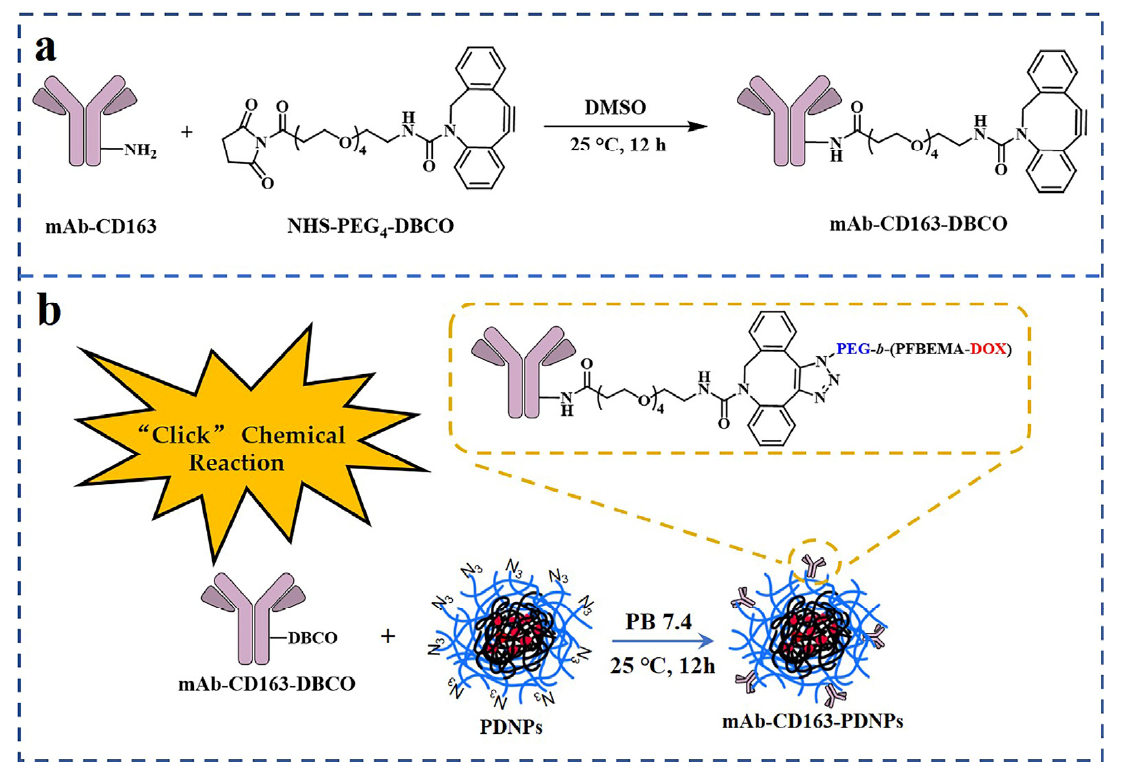
Scheme 3. Schematic illustration for modification of antibodies and preparation of nanoparticles. Table 2. CD163 mAb modification amount in different samples of mAb-CD163-PDNPs.